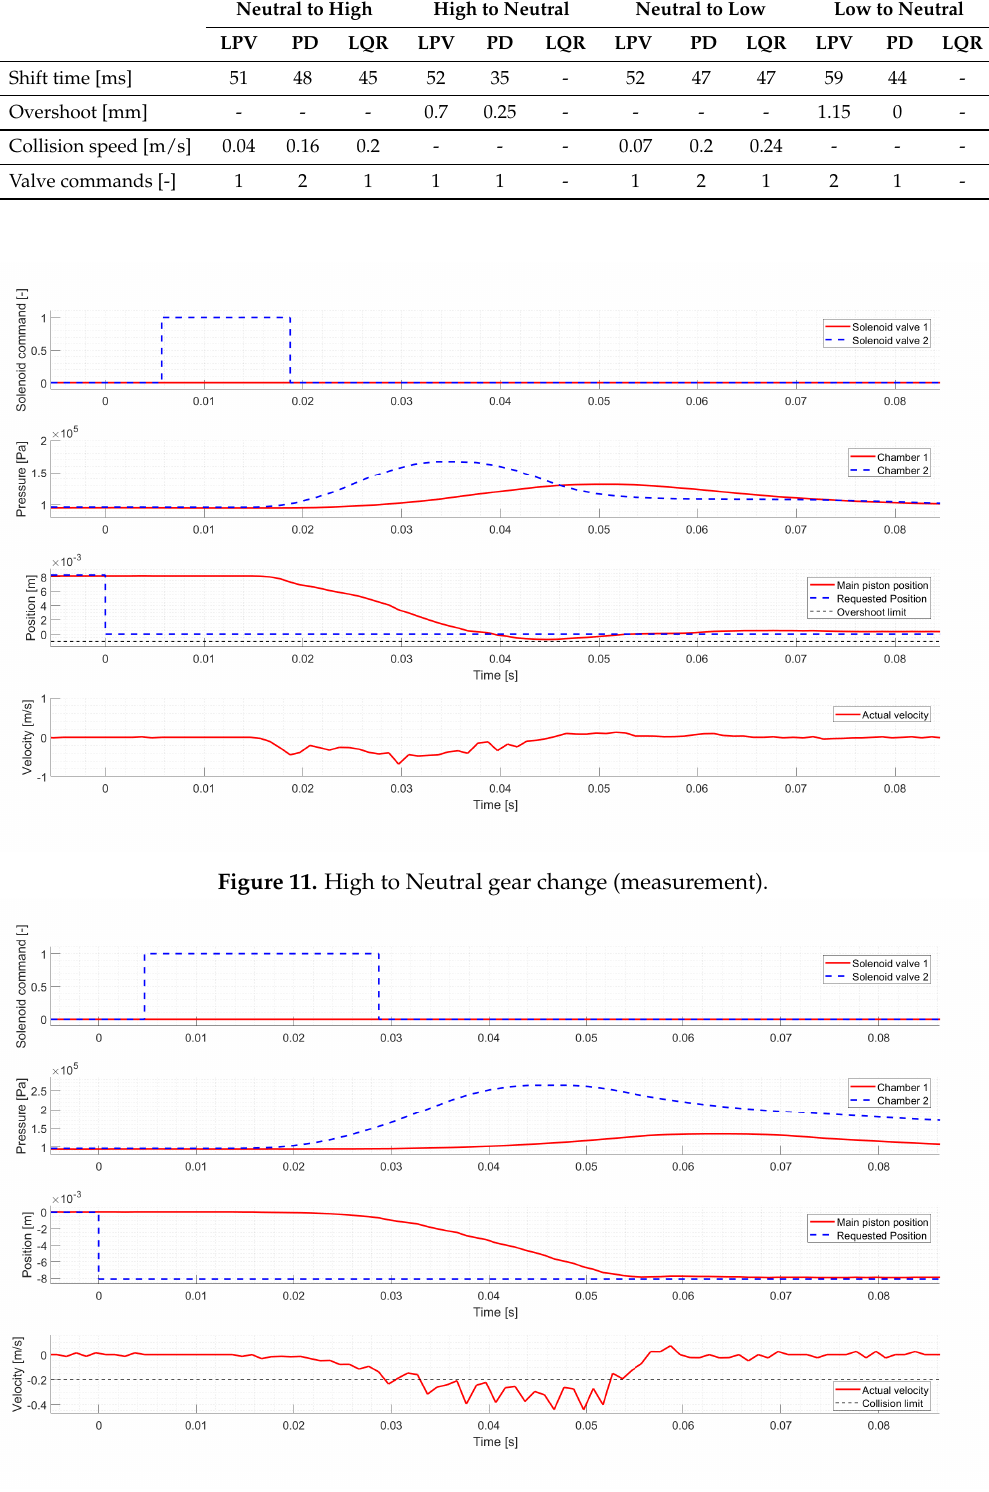
Figure 12. Neutral to Low gear change